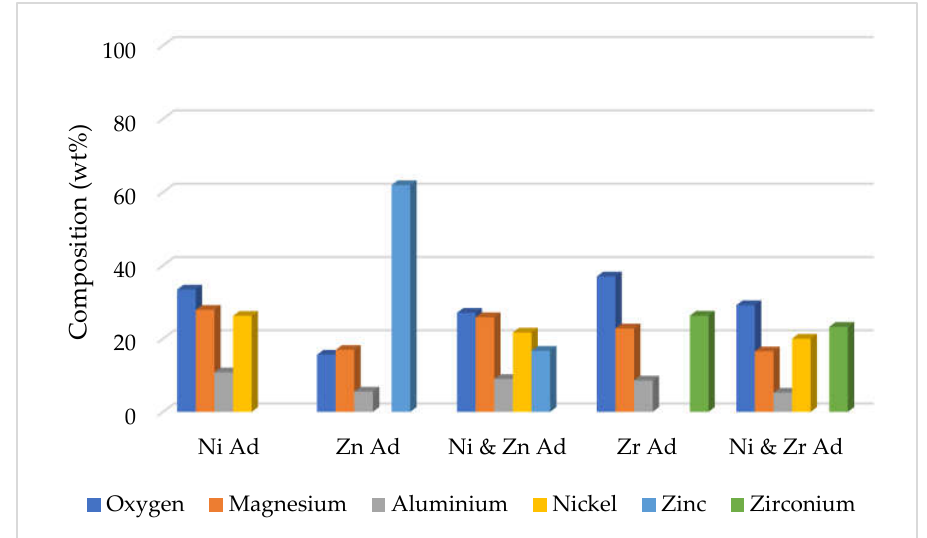
Figure 4. Elemental composition of the five calcined adsorbents from energy dispersive X-Ray analysis (EDAX).